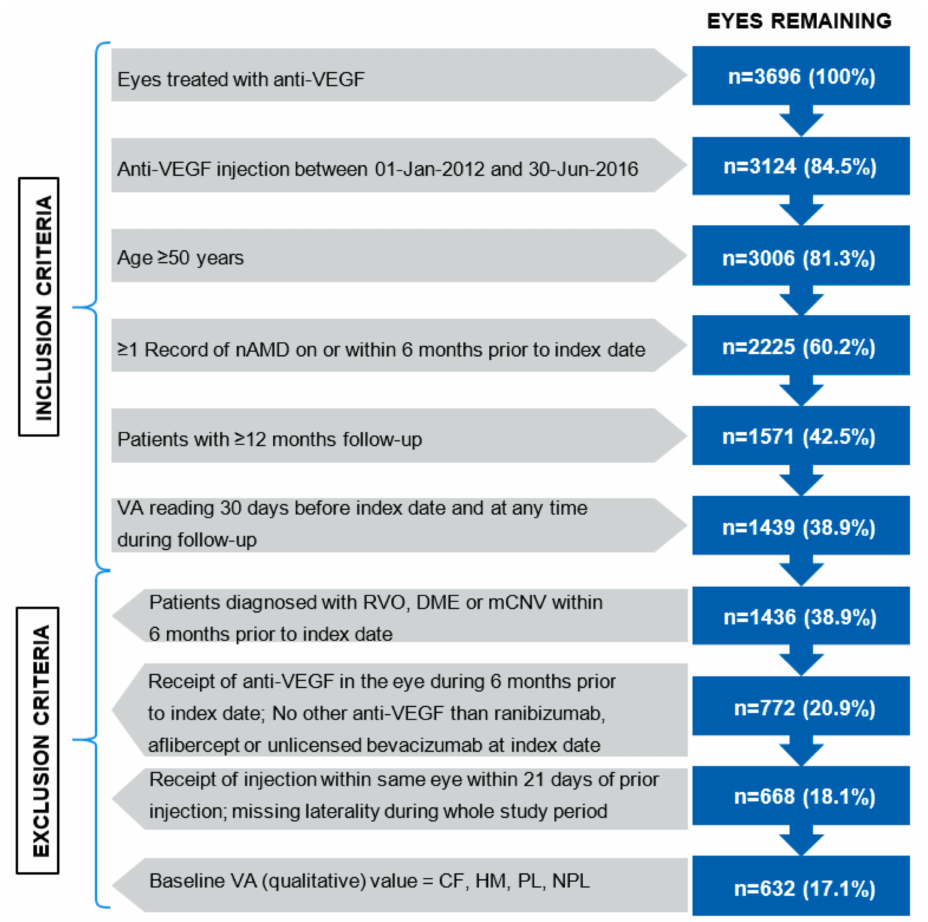
Figure 2. Flowchart describing attrition of the study sample. RVO; retinal vein occlusion, DME; diabetic macular edema, mCNV; myopic choroidal neovascularisation, CF; count fingers, HM; hand motion, PL; light perception, NPL, no light